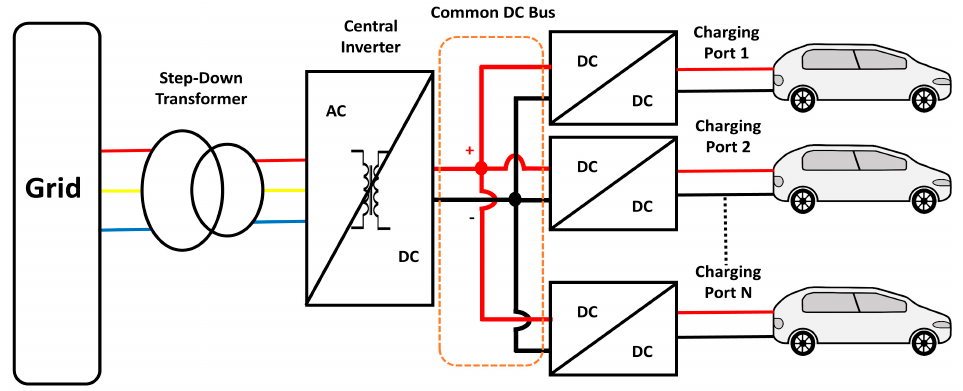
Figure 6. The charging station of BEVs and PHEVs with common DC bus architecture [6].